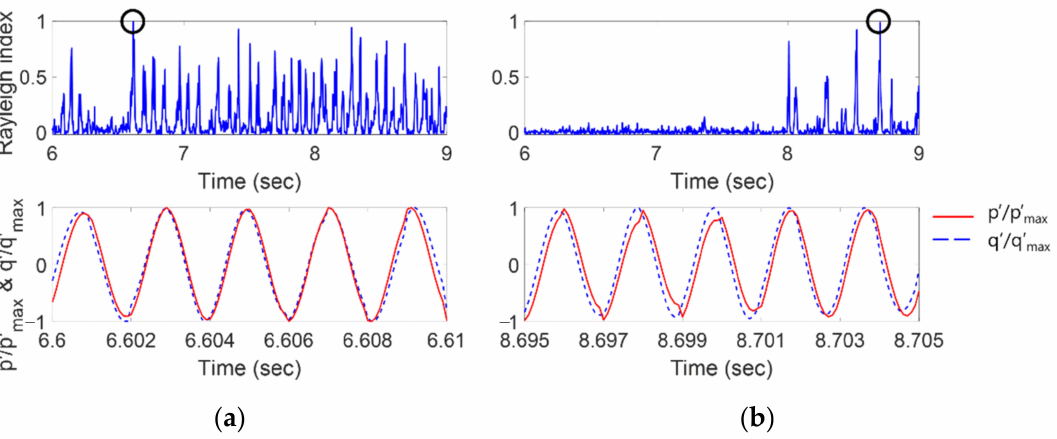
Figure 6. Rayleigh index (RI) and overlay of normalized p (cid:48) and q (cid:48) in ( a ) baseline and ( b ) test